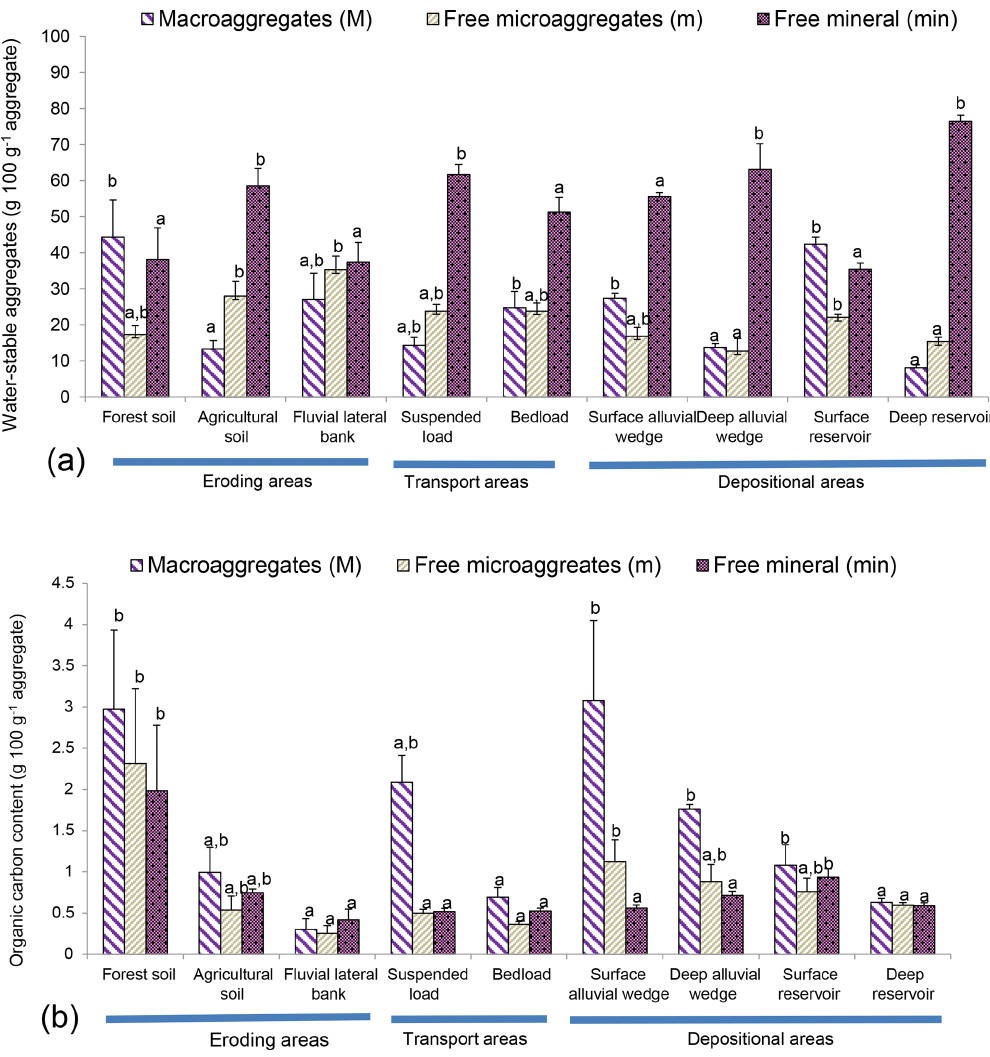
Figure 3. (a) Water-stable aggregate size distribution (g aggregate 100g − 1 soil) for >250µm (macroaggregates: M), 63–250µm (free mi- croaggregates, m), and <63µm (free mineral fraction: min) in different geomorphological positions within the catchment: eroding, transport, and depositional areas. Numeral values are means ± SE. Bars with different lowercase letters indicate significant differences in the percent- age of each water-stable aggregate size among the different soils and sediments ( p< 0 . 05) according to the Kruskal–Wallis test. (b) Organic carbon content (g 100g − 1 aggregate) for >250µm (macroaggregates: M), 63–250µm (free microaggregates, m), and <63µm (free mineral fraction: min) in different geomorphological positions within the catchment: eroding, transport, and depositional areas. Numeral values are means ± SE. Bars with different lowercase letters indicate significant differences in the percentage of each water-stable aggregate size among the different soils and sediments ( p< 0 . 05) according to the Kruskal–Wallis